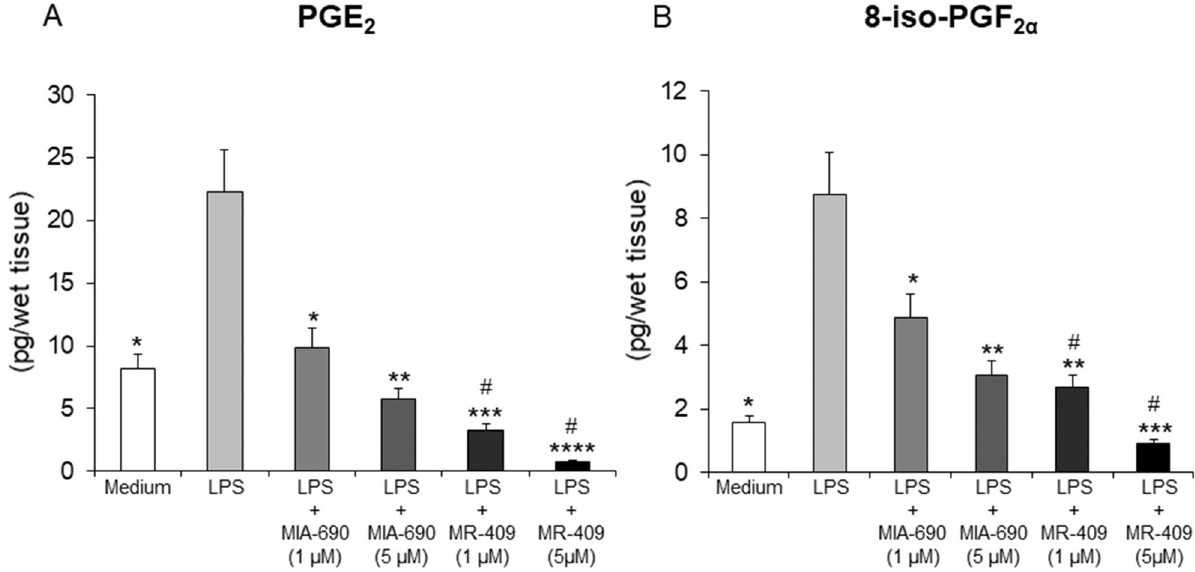
Figure 1. Inhibitory effects of MIA-690 (1 and 5 μM) and MR-409 (1 and 5 μM) on PGE 2 ( A ) and 8-iso-PGF 2α ( B ) levels, ex vivo (n = 5 for each group of treatment). Data are expressed as means ± S.E.M. and analyzed by analysis of variance (ANOVA) followed by Bonferroni post-hoc test * p < 0.05, ** p < 0.01, *** p < 0.005, **** p < 0.001 versus LPS; # p < 0.05 versus treatment with